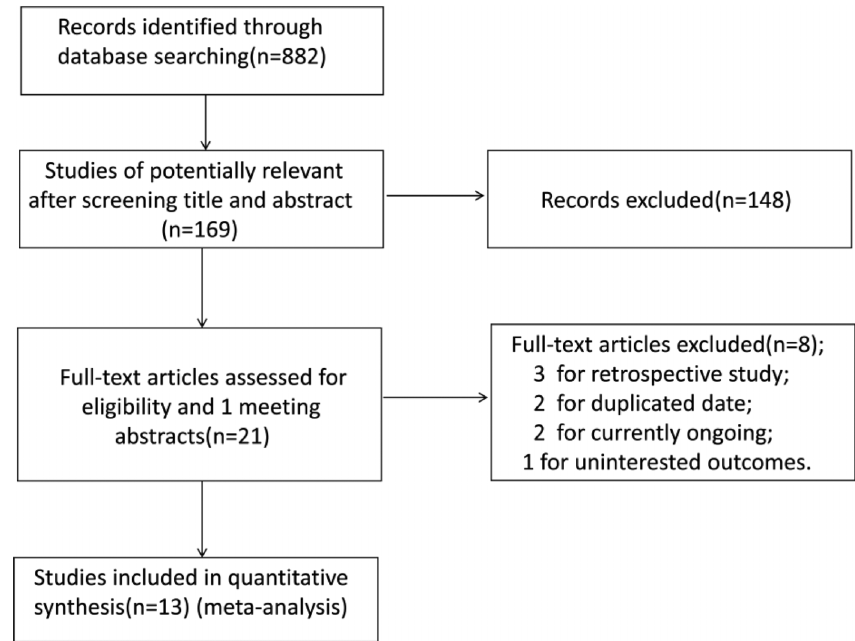
Figure 1 - Flow chart showing article selection.